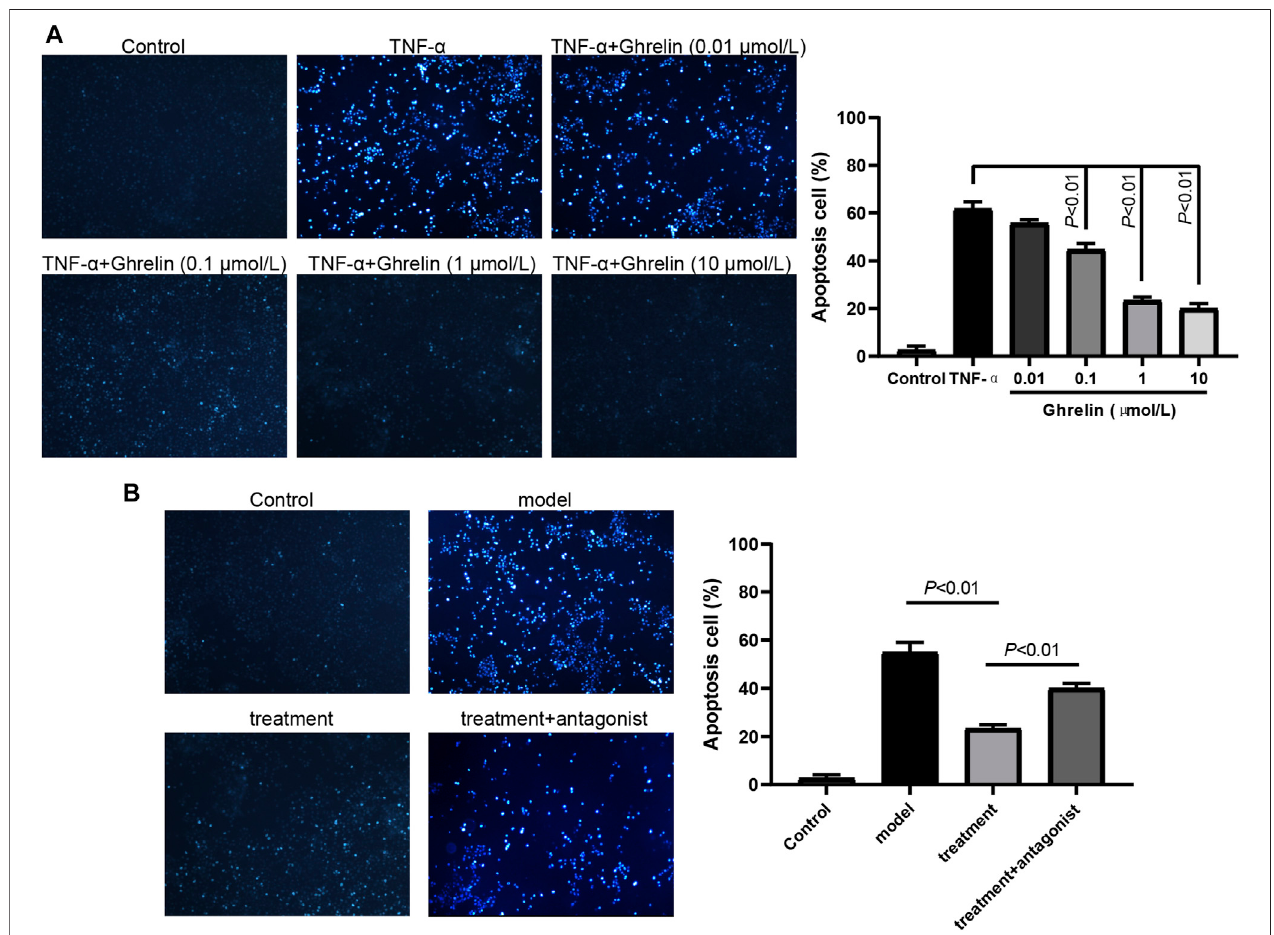
FIGURE 1 | Ghrelin inhibits TNF- α -induced apoptosis of Caco-2 cells through GHS-R1a. (A) Caco-2 cells were treated with ghrelin, and apoptosis was observed by Hoechst 33258 staining. Ghrelin inhibited apoptosis at the dose from 0.01 μ mol/L to 10 μ mol/L. Data were shown as means ± SD (n (cid:2) 3). (B) Caco-2 cells were treated with ghrelin in addition to [D-lys3]-GHRP-6, and apoptosis was observed by Hoechst 33258 staining. Data were shown as means ± SD (n (cid:2)